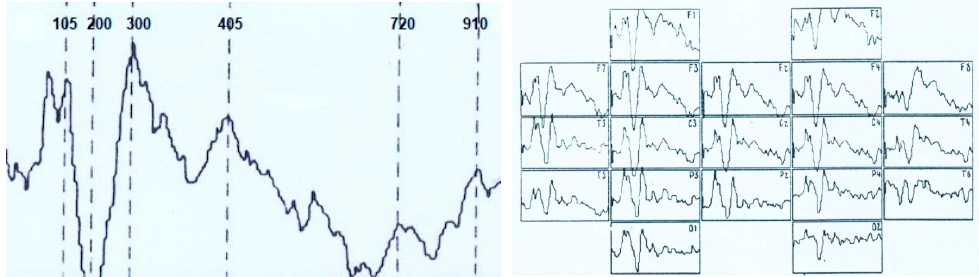
Figure 1. Visual evoked potential (numbers–time, ms) and VEP distribution according to the 10–20 system in the perception of an identifiable visual image. Analysis time—1000 ms.